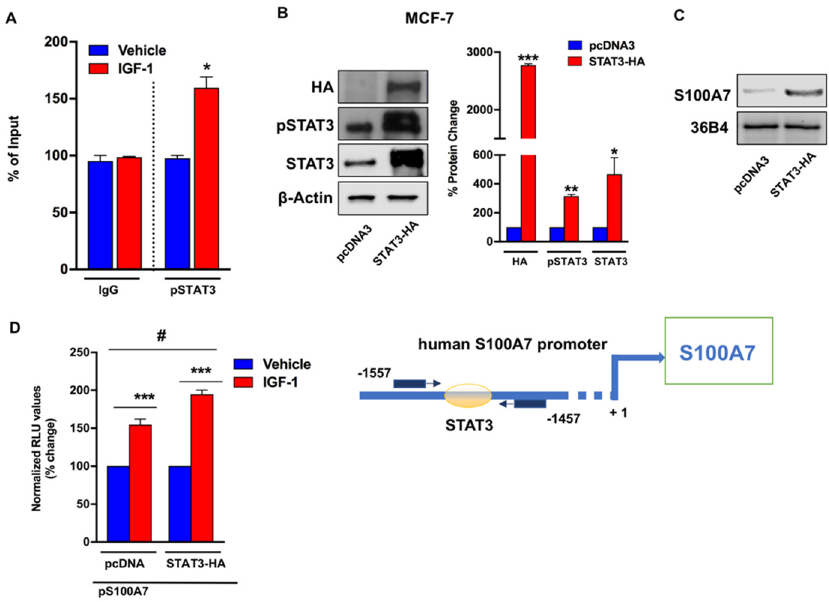
Figure 5. STAT3 is involved in the transcriptional activation of S100A7 by IGF-1. ( A ) IGF-1 (10 nM, 24 h) induces the recruitment of STAT3 (Y705) to the STAT3 binding site located within the S100A7 promoter sequence, as ascertained by Chromatin Immunoprecipitation (ChIP)-RT-PCR assay per- formed in MCF-7 cells. In control samples, nonspecific IgG was used instead of the primary antibody. Data shown are the mean ± SEM of at least two independent experiments performed in duplicate. ( B ) Representative immunoblots of HA, pSTAT3 (Y705), and STAT3 in MCF-7 cells which were transiently transfected with pcDNA3 and STAT3-HA for 48 h, to generate a constitutively activated STAT3 system. ( C ) Evaluation of S100A7 mRNA expression by RT-PCR in MCF-7 cells transfected with pcDNA3 and STAT3-HA for 48 h, as indicated. 36B4 gene serves as normalizing control. ( D ) The transactivation of a S100A7 (pS100A7) promoter plasmid observed after treatment with IGF-1 (10 nM, 18 h) is enhanced in MCF-7 cells transfected for 48 h with STAT3-HA, compared with cells transfected with pcDNA3 control vector. Results are expressed as the % change of normalized RLU values relative to vehicle-treated cells. Data shown represent the mean ± SEM of at least two independent experiments performed in triplicate. (*), (#) p < 0.05; (**) p < 0.01; (***) p < 0.001. Side panel shows a schematic representation of human S100A7 promoter carrying the STAT3-responsive site.